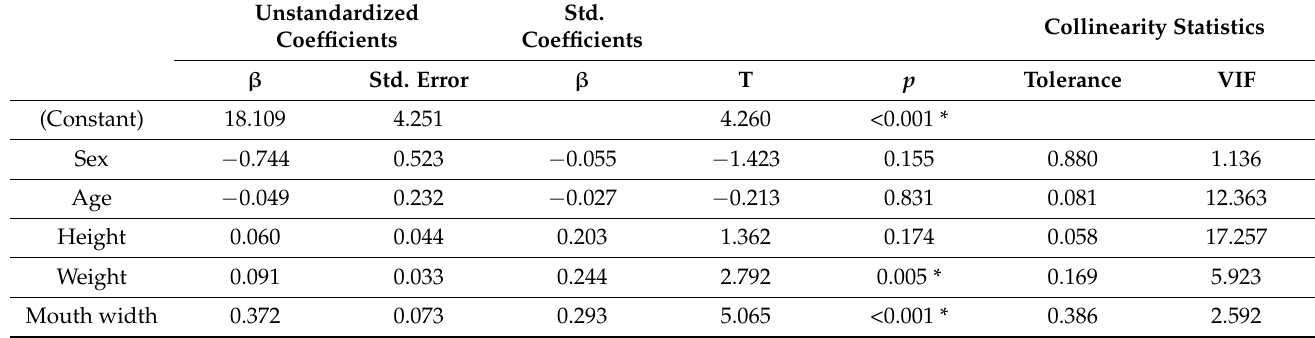
Table A3. Multiple linear regression analysis of the association between maximum mouth opening and sex, age, height, weight, and mouth